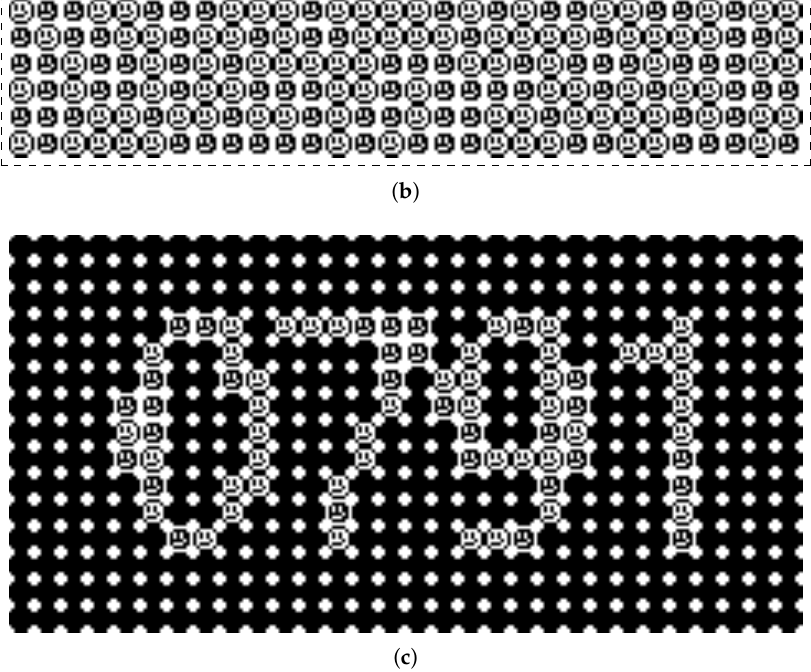
Figure 11. Results obtained by personalization of shares with the proposed pictogram-based VC technique. Emoticon-based positive and negative binary masks have been designed for share stylization from a PIN image. The appearance of the generated shares is made aesthetic and used as a new medium of communication. ( a ) Generated Stylized Share 1 (encrypted image); ( b ) Generated Stylized Share 2 (encrypted image); ( c ) decoded PIN number by share